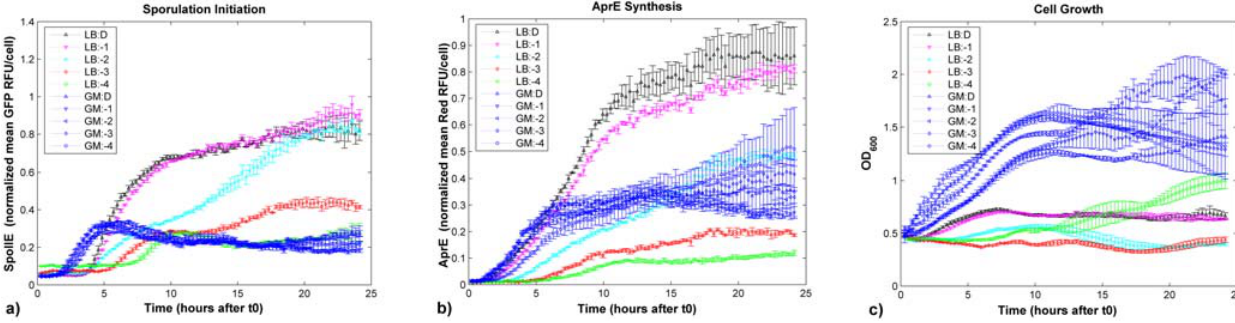
Figure 5. B.subtilis memory data compendium. These plots show the dynamics of the sporulation initiation reporter P spoIIE-gfp expression (a), the degradative enzyme synthesis reporter P aprE-dsred expression (b), and cell growth (c) of B. subtilis KEE after the onset of starvation (resuspension in SM) as a function of cell history prior to starvation, as measured by fluorescence (GFP, and DsRed) and OD 600 time series measurements taken every 15 minutes for 24 hours, respectively. The 10 cell histories tested consisted of growth in either rich LB medium or poorer GM medium to one of five densities D, 2 1, 2 2, 2 3, 2 4, (see experimental overview section and Materials and Methods for details). Fluorescent intensities in (a–b) were divided by OD600 (c) and then normalized to a [0 1] scale by dividing by the maximum. The error bars show standard deviation over replicates at each time